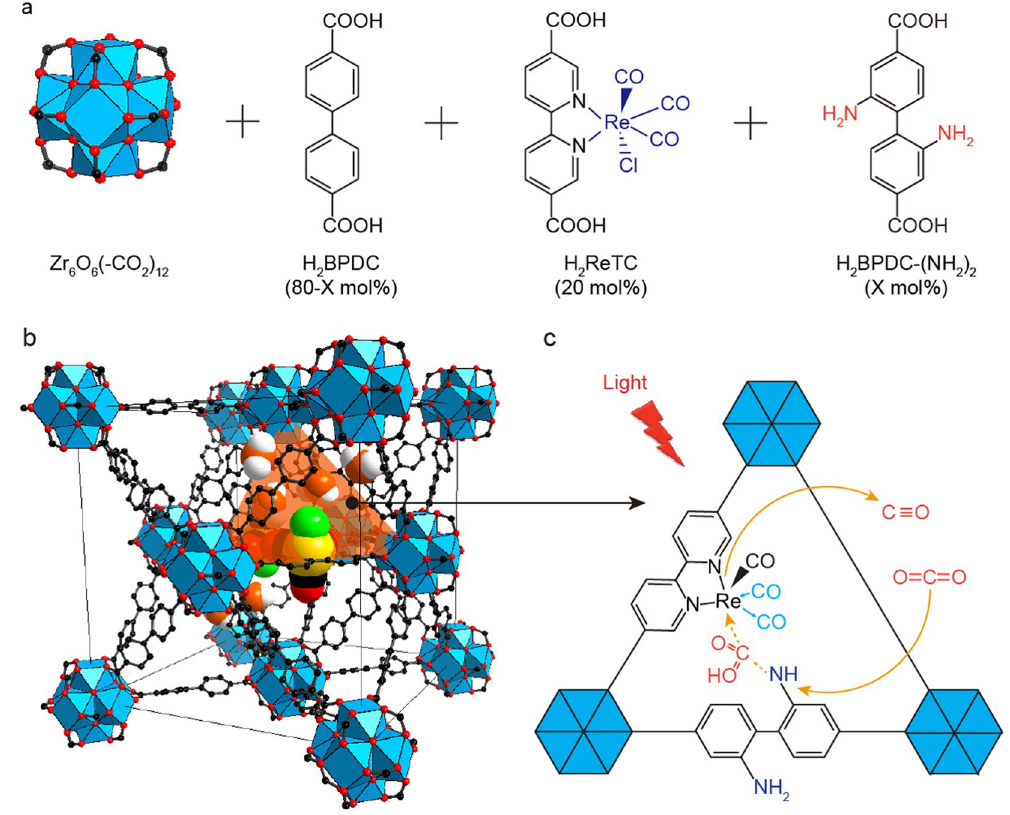
Figure 1. Schematic diagram for the ─ NH 2 -functionalized Re-MOF that converts CO 2 to CO under visible light. ( a , b ) Zr 6 O 4 (OH) 4 (–CO 2 ) 12 secondary building units (SBUs) are combined with H 2 BPDC, H 2 ReTC and H 2 BPDC-(NH 2 ) 2 linkers to form Re-MOF-(NH 2 )(X%). The structure of Re-MOF-NH 2 (X%) is shown. Twelve-coordinated Zr-based metal clusters are interconnected by BPDC, ReTC and BPDC-(NH 2 ) 2 linkers in a face-centred cubic array. Atom labelling scheme: C, black; O, red; Zr, blue polyhedra; Re, yellow; Cl, green; H atoms are omitted for clarity. ( c ) A schematic diagram of the photocatalytic CO 2 conversion within Re- MOF-NH 2